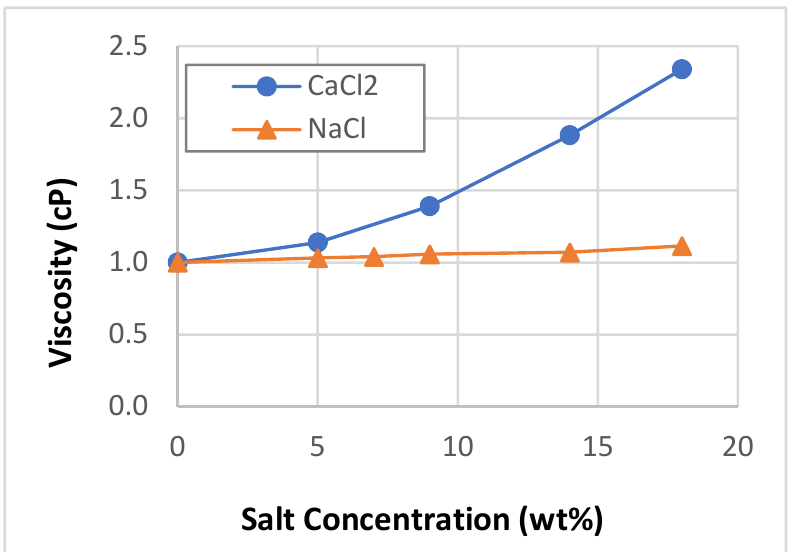
Figure 4. Viscosity of water vs. salt concentration. Foam rheology tests were performed to ensure proper foam generation for drainage experiments and study the effect of salt concentration on the flow behavior of aqueous foams. In Figure 5, rheology measurements of NaCl salt-containing foams. The data